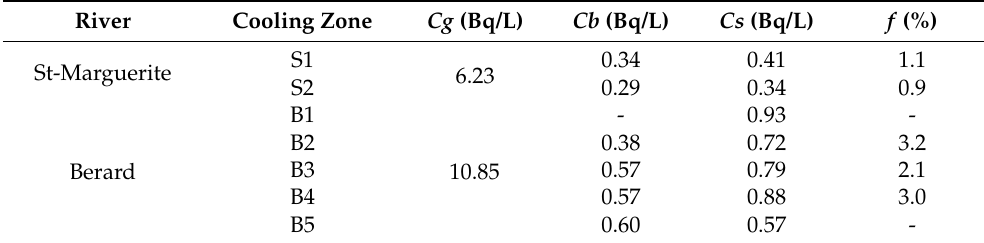
Table 1. Calculated fraction of GW in the identified cooling sections of the rivers.